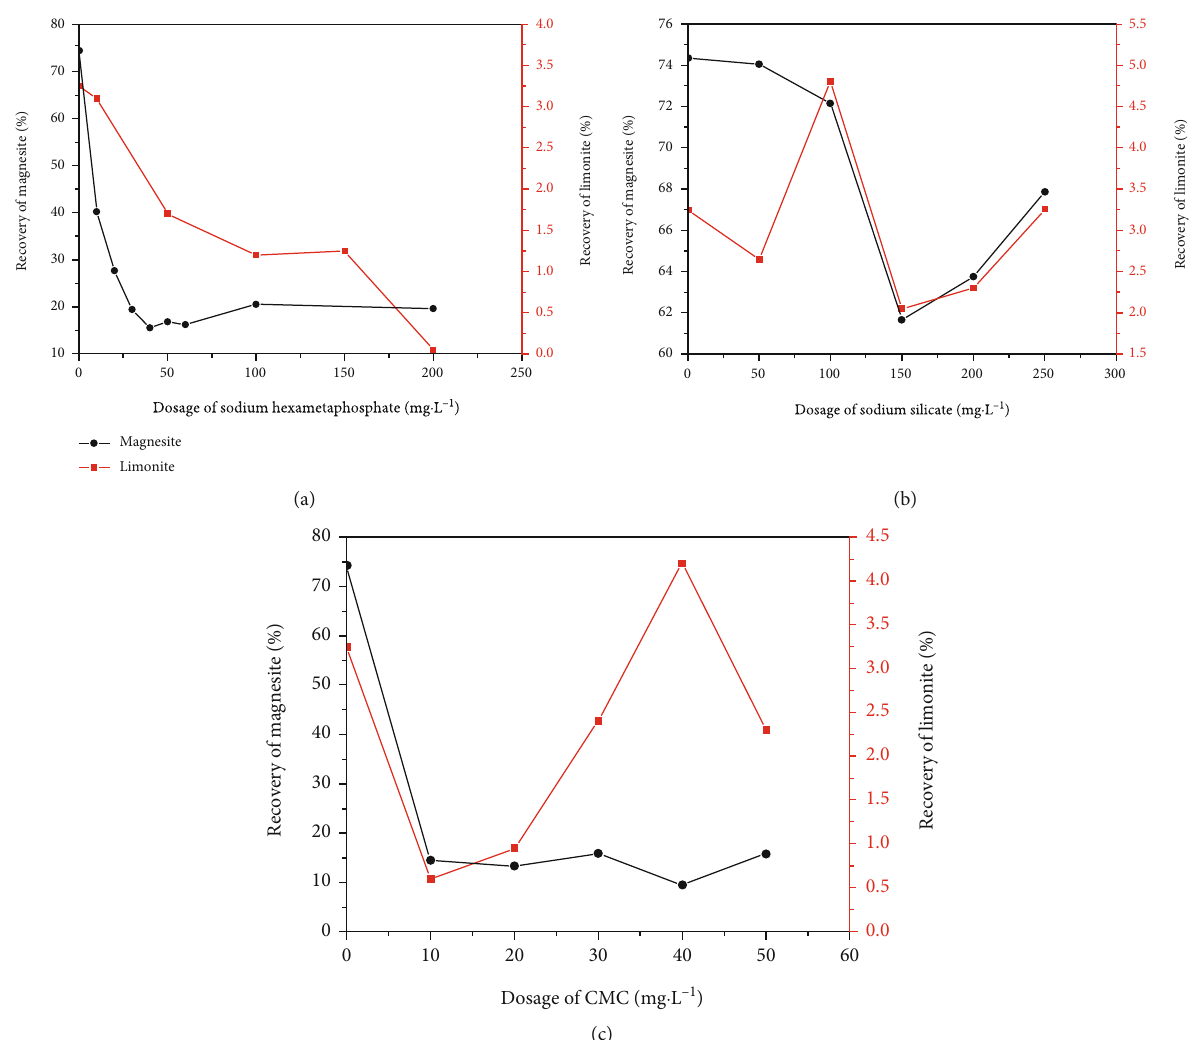
Figure 5: E ff ects of sodium hexametaphosphate (a), sodium silicate (b), and CMC (c) on the fl oatation ratios of magnesite and